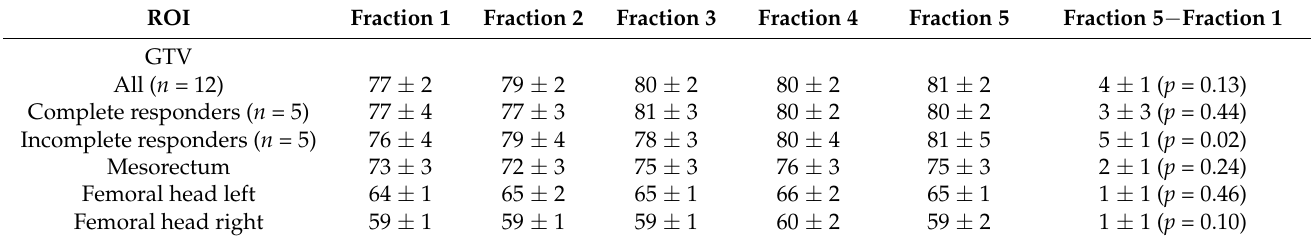
Table 3. Group mean T 1 ρ values for each ROI and treatment fraction: The values are presented in ms as mean ± standard error of the mean (SEM). The last column shows the mean ± SEM of the paired differences between fraction 1 and fraction 5. The p -values for the difference between the first and last fraction were calculated using a paired t